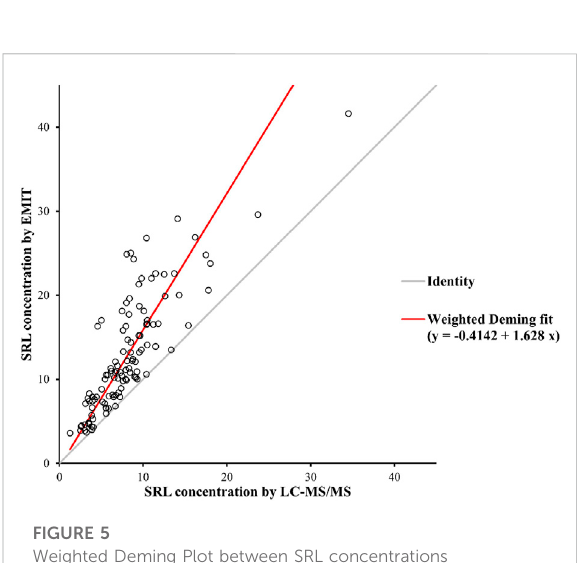
Weighted Deming Plot between SRL concentrations generated by the EMIT and LC-MS/MS